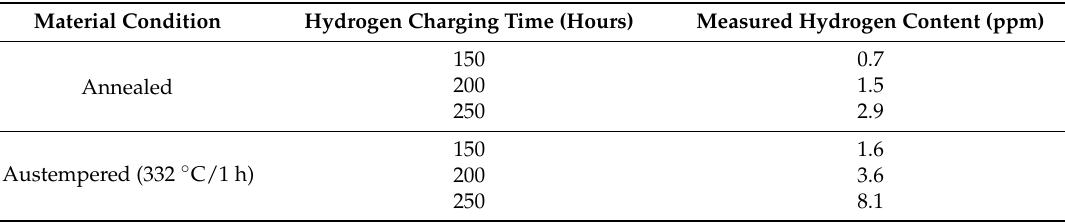
Table 4. The Effect of Charging Time on the Dissolved Hydrogen Content of the 4140 Steel.